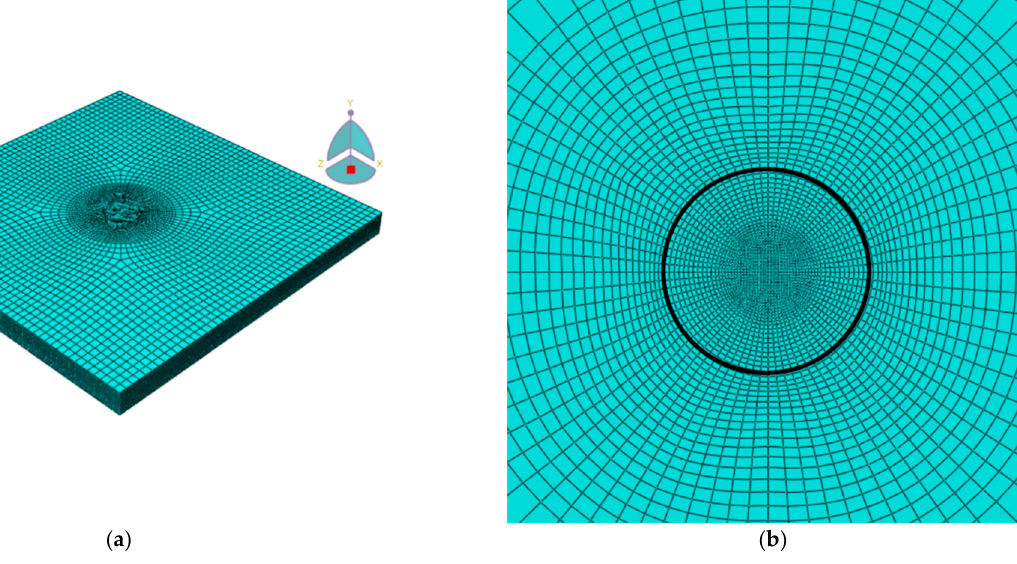
Figure 1. 3D finite element mesh of three-layer tissue of animal origin model: ( a ) whole model—side view; ( b ) enlargement of central part of the model—top view.